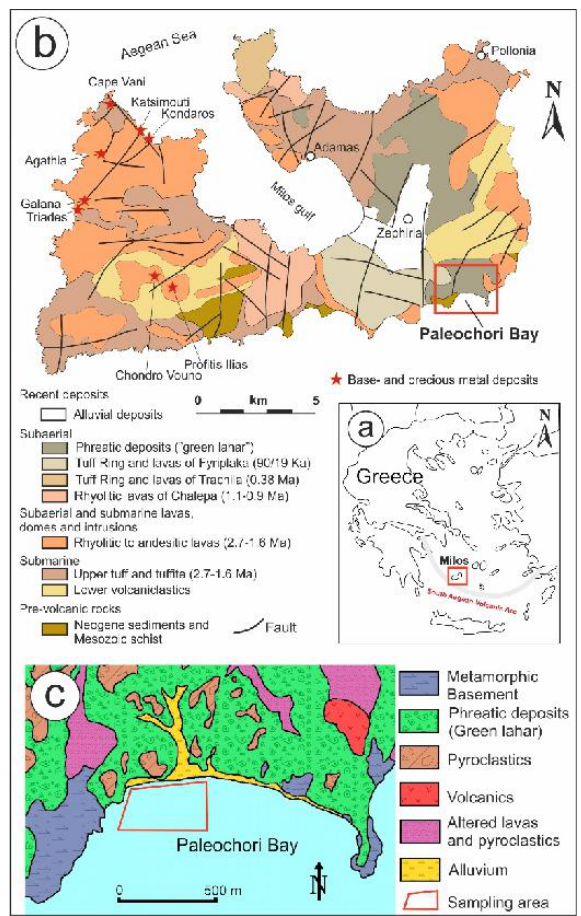
Figure 2. ( a ) Location of Milos island in the central part of the South Aegean Volcanic Arc; simplified geological map of ( b ) Milos island (modified from Fytikas et al. [74]; Stewart and McPhie [75], Alfieris et al. [58]; and Voudouris et al. [80]); and ( c ) of the Paleochori Bay showing sampling area (based on Kati et al. [67,68]).